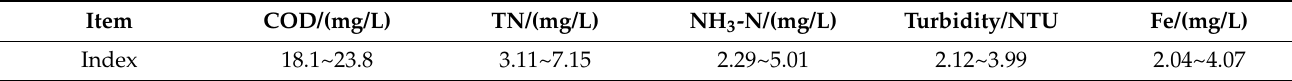
Table 2. Quality index of experimental raw water.